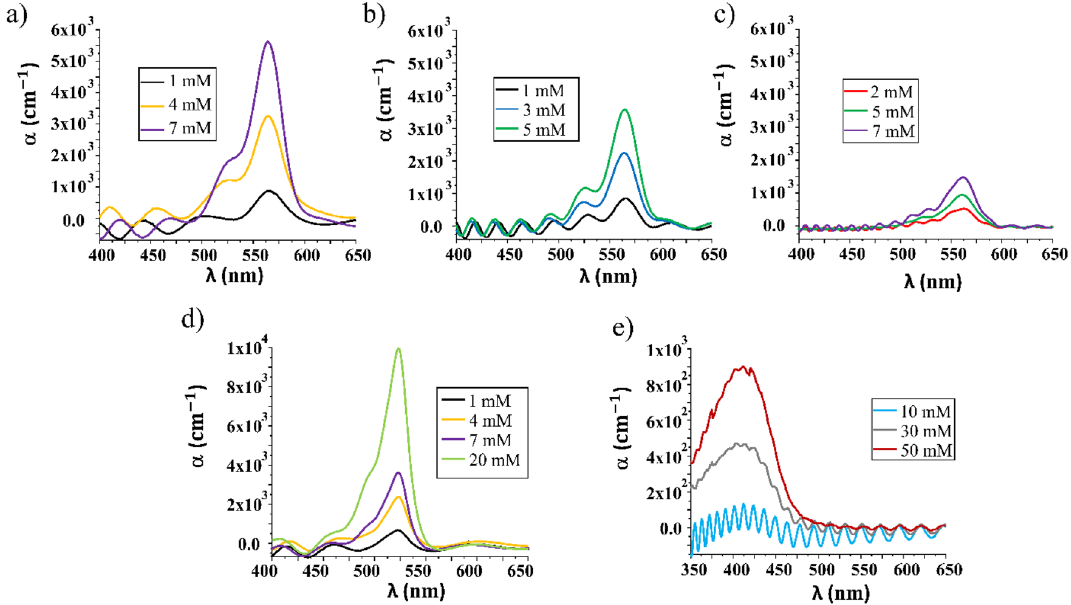
Figure 3. Spectral distribution of absorption coefficient (α) curve of SU8, EpoCore and OrmoStamp thin films ( a ) SU8 doped with RhB at concentrations of 1 mM, 4 mM and 7 mM, with 1.2 µm of thickness, ( b ) EpoCore doped with RhB at concentrations of 1 mM, 3 mM and 5 mM, with 2 µm of thickness, ( c ) OrmoStamp doped with RhB at 2, 5 and 7 mM of concentration, with 4.4 µm of thickness, ( d ) SU8 doped with Py580 at 1 mM, 4 mM, 7 mM and 20 mM, with 1.2 µm of thickness, and ( e ) OrmoStamp doped with C540A at 10 mM, 30 mM and 50 mM with 4.4 µm of thickness. All concentrations reflect the dye concentration in the